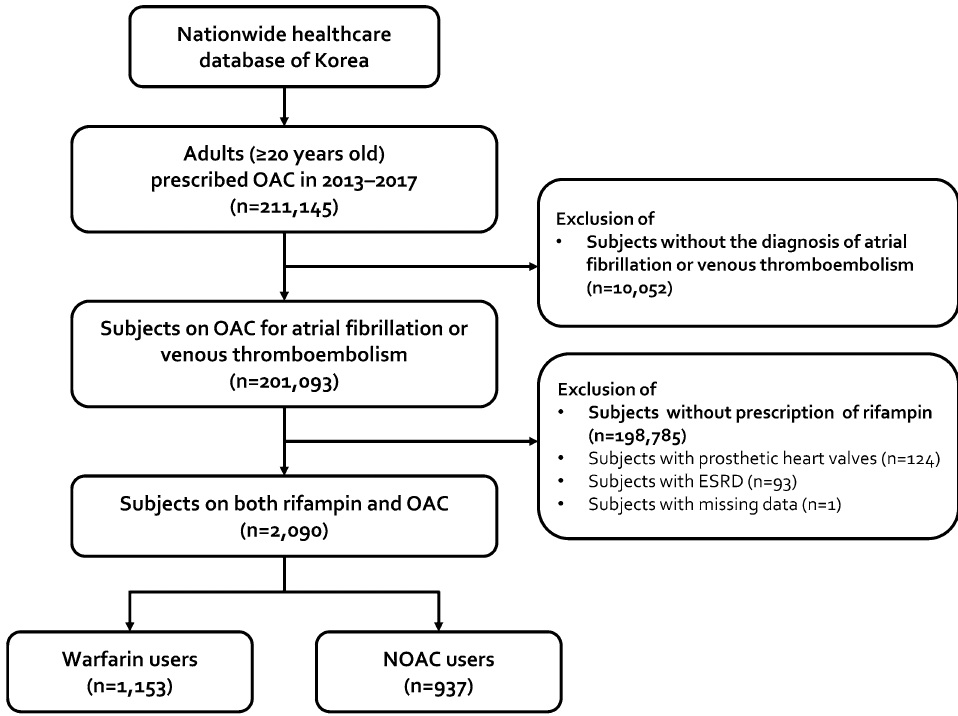
Figure 1. Study inclusion flow. OAC oral anticoagulant, NOAC non-vitamin K antagonist oral